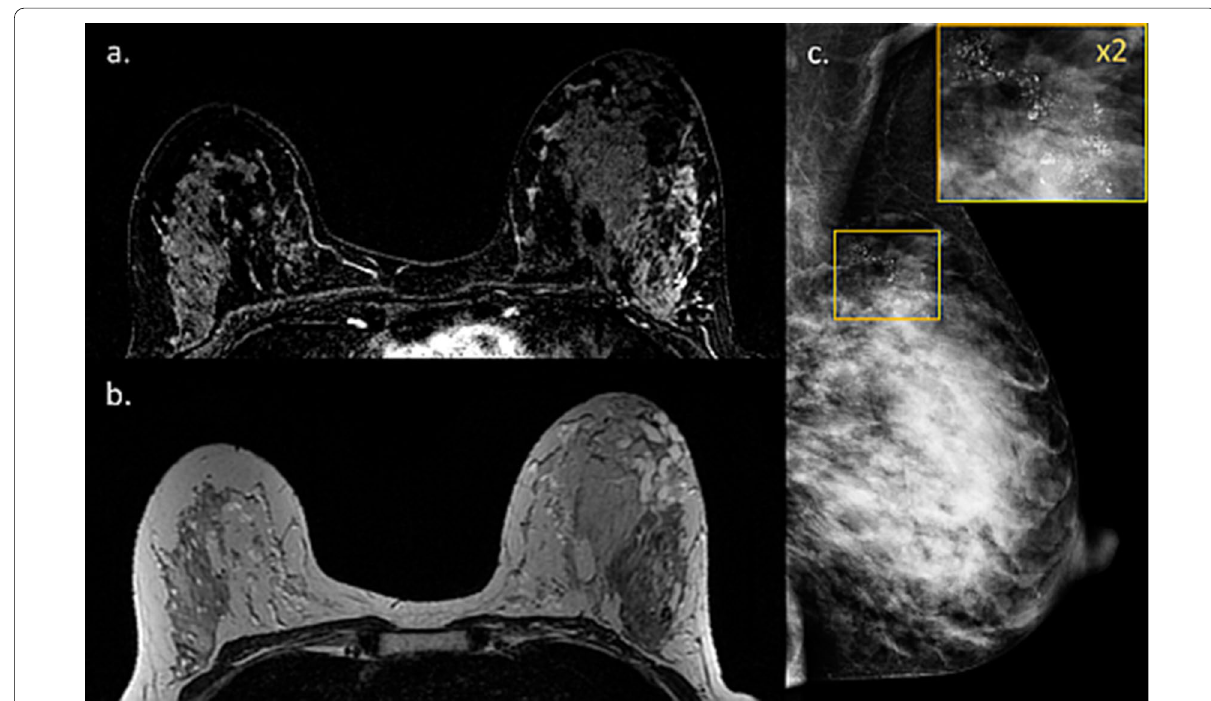
Fig. 15 MRI of DCIS during lactation. Images of a 40‑year‑old PABC patient (lactating for 4 months) with DCIS confirmed on operation are presented. The patient underwent screening mammography with adjuvant breast US (not presented) due to the extremely dense breasts on mammography (BI‑RADS D) ( c ). Mammography revealed suspicious pleomorphic micro‑calcifications in segmental distribution along 6 cm in the left upper outer quadrant ( c ). Pre‑operative MRI showed NME on top of the surrounding prominent lactation‑induced BPE, typical for DCIS, in agreement with the calcifications location ( a ). Furthermore, an excellent tumor delineation was afforded by non‑fat surpassed T2‑weighted image, showing hypo‑intense region in the tumor area ( b )